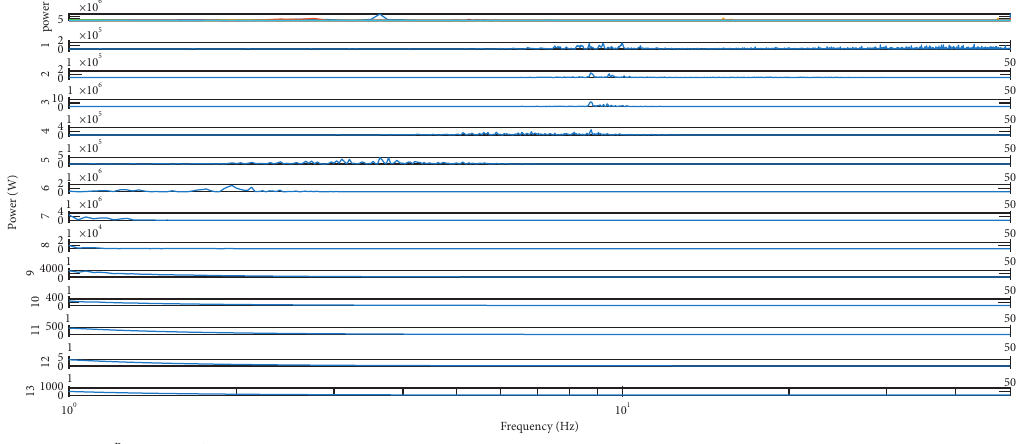
Figure 9: The IMF component in the time